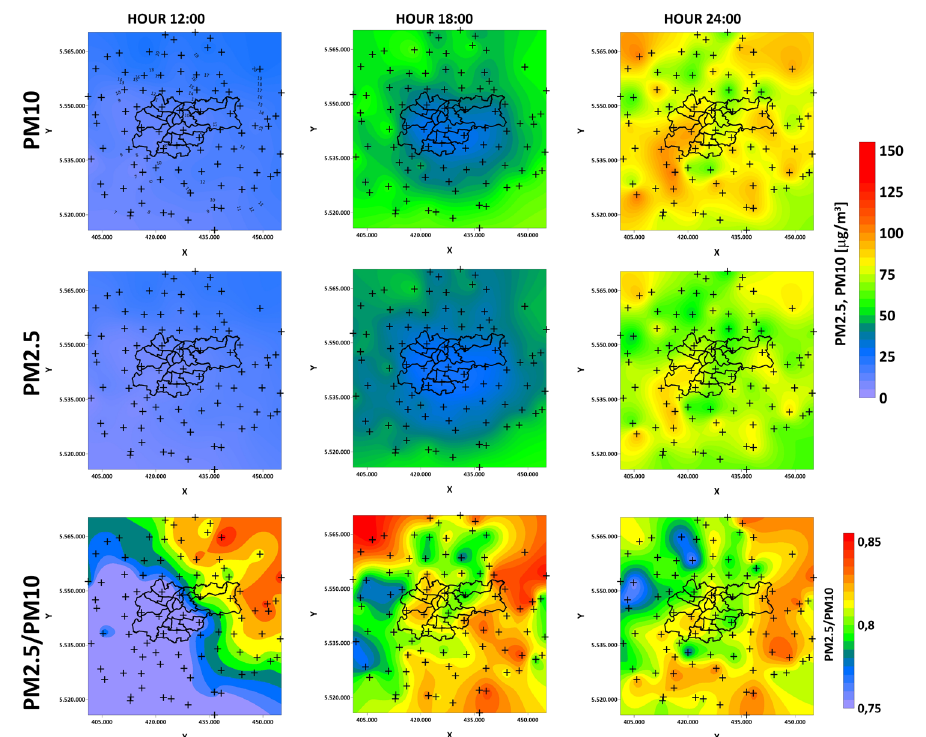
Figure 13. PM10 and PM2.5 GWR models with their ratio on the 18th of March